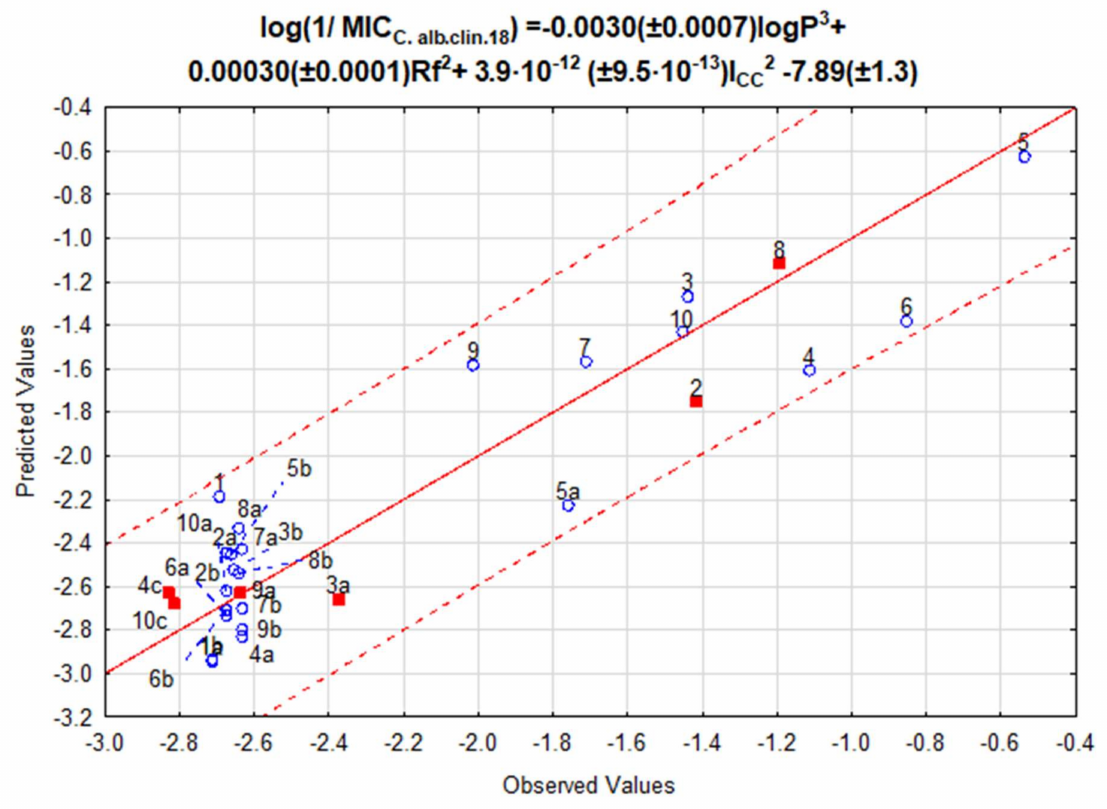
Figure 1. Correlation of activity against Candida albicans clinical isolate 18 and logP 3 , Rf 2 , I CC2 . Dashed lines mark the area of predictability of the received models, which are described by the equations (cid:4) featured above the graphs. —test set, ◦ —training